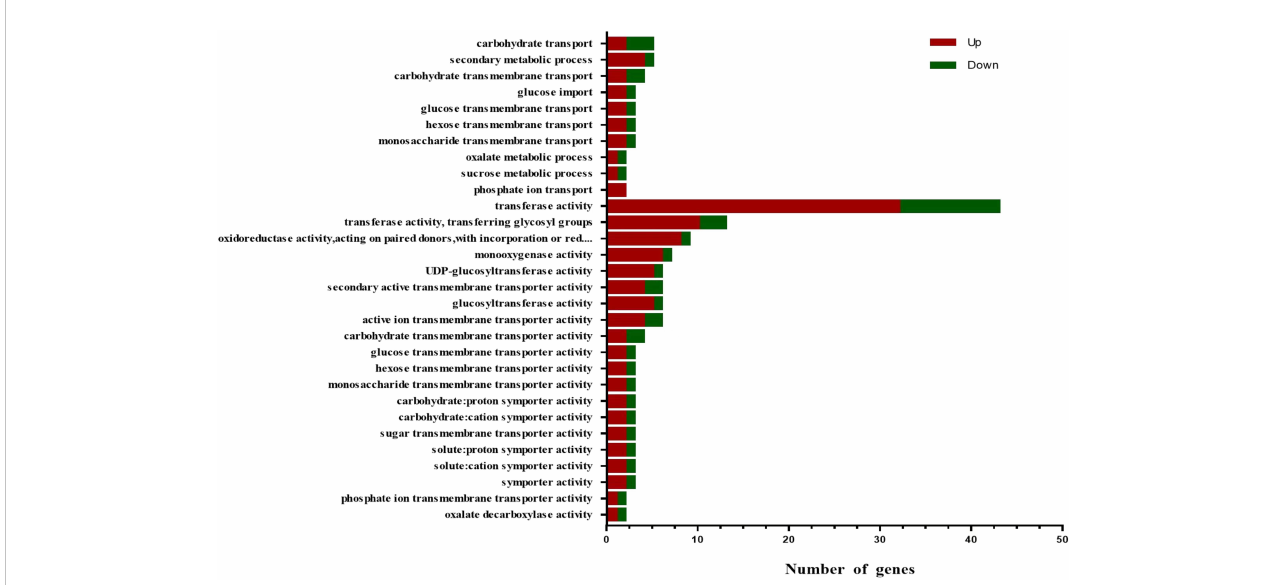
FIGURE 8 Gene Ontology (GO) analysis of differentially expressed genes. Red indicates genes with increased expression, and green indicates genes with decreased expression. BP, biological processes; MF, molecular function.